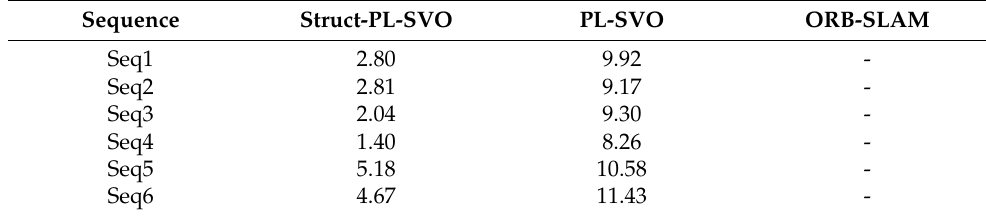
Table 3. Absolute RMSE (m) errors in the ceiling wheeled robot